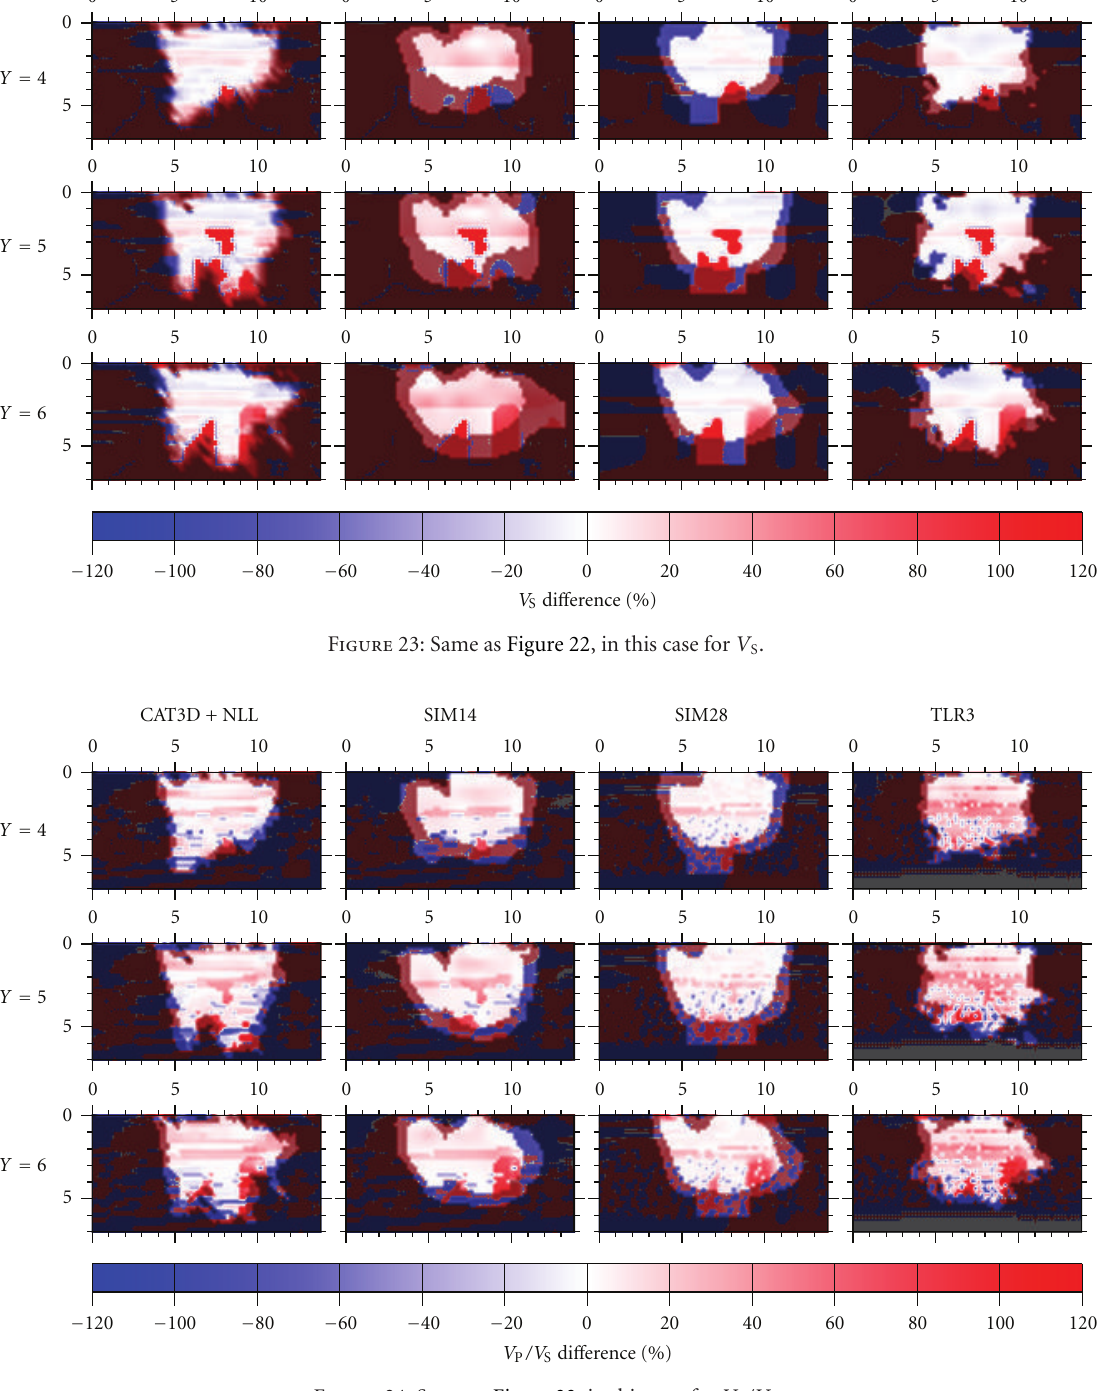
Figure 24: Same as Figure 22, in this case for V P /V S